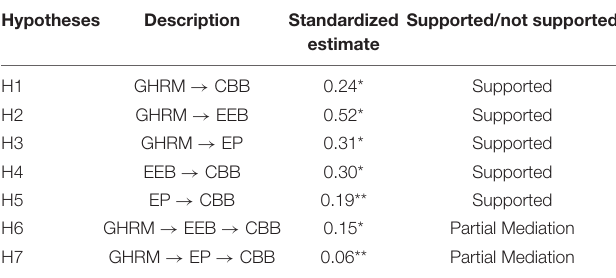
TABLE 5 | Hypotheses